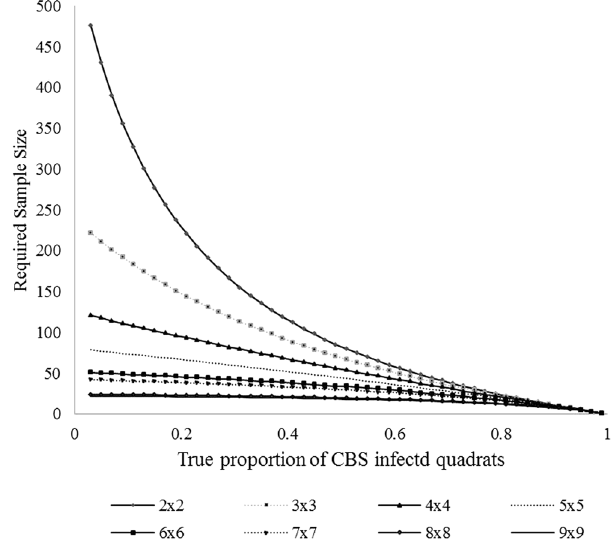
Figure 4. Required sample size for Grove I as a function of the true proportion of CBS infected quadrats for a (1 − α )100% = 95% confidence interval with 20% relative precision. Each line represents the required sample size for differing sizes of quadrats containing differing numbers of